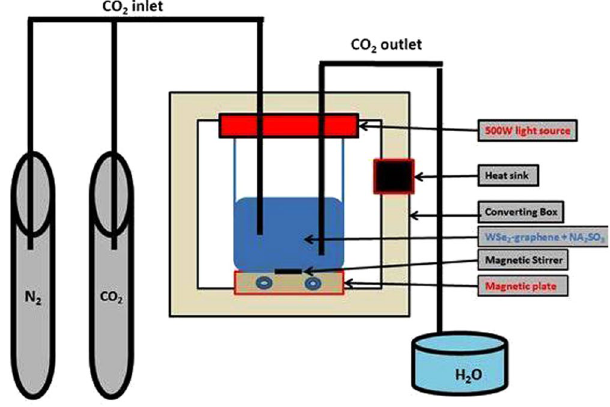
Figure 1. The schematic diagram of CO 2 reduction